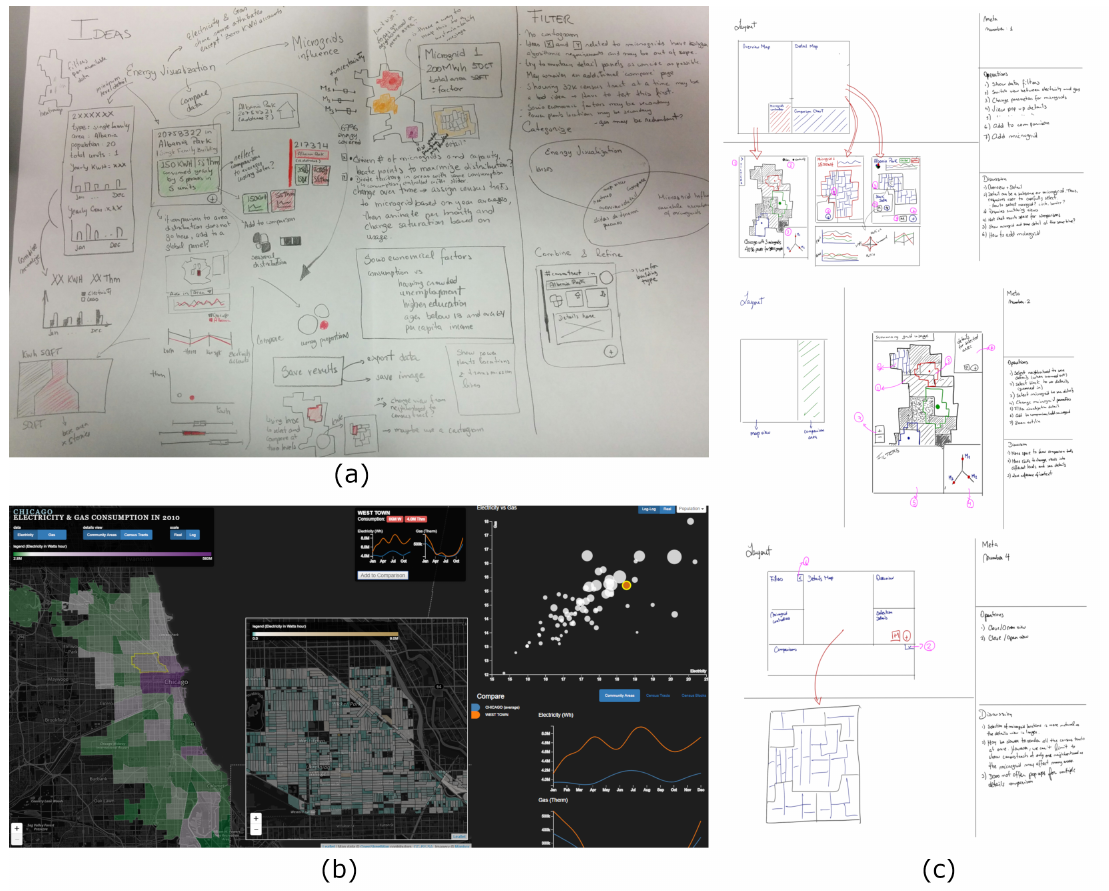
Figure 3. Parallel prototyping in the design stage. ( a ) Prototypes for visual encodings. ( b ) Early software prototype with reduced functionality, whose look and feel the end-users critiqued as ‘too Unix/computerish’. ( c ) Workflow and layout